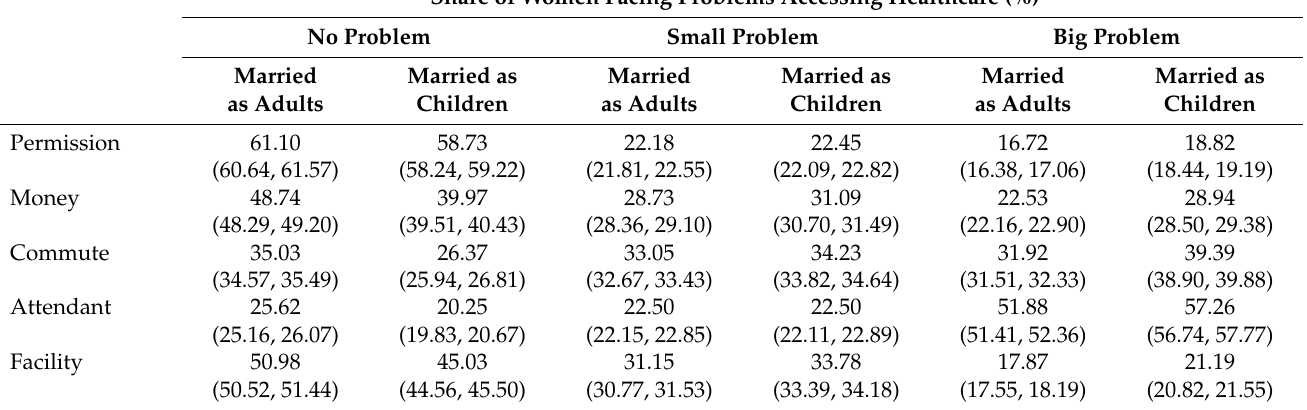
Table 2. Share of women reporting different degrees of problems for each factor according to marriage age.